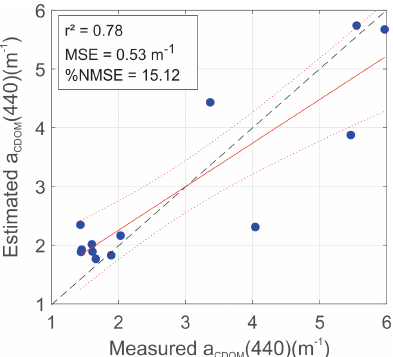
Figure 6. Measured versus estimated a CDOM ( 440 ) (m − 1 ). Equa- tion (4) was used to estimate a CDOM ( 440 ) ( y axis). The red solid line indicates the regression line between the measured and esti- mated values, the two red dotted lines show the 95% confidence interval, and the black dashed line is the 1:1